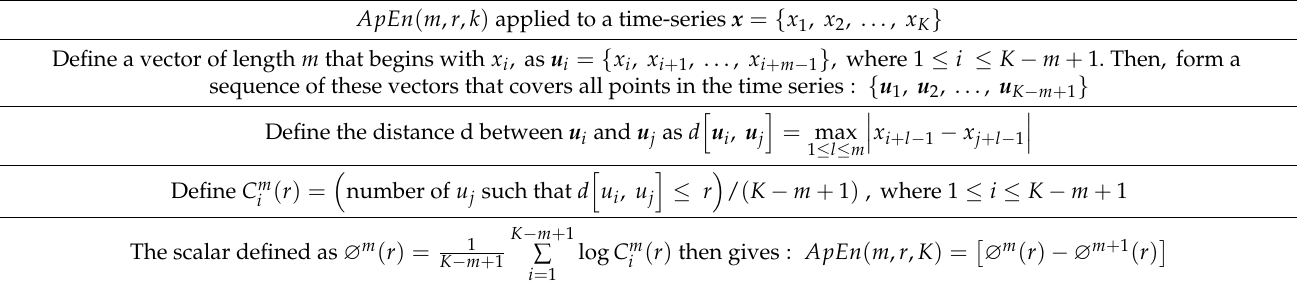
Table 2. Definition of approximate Entropy ( ApEn ) as proposed in [35]. We used parameter values of m = 2 and r = 0.2 × sd ( x ) as recommended in